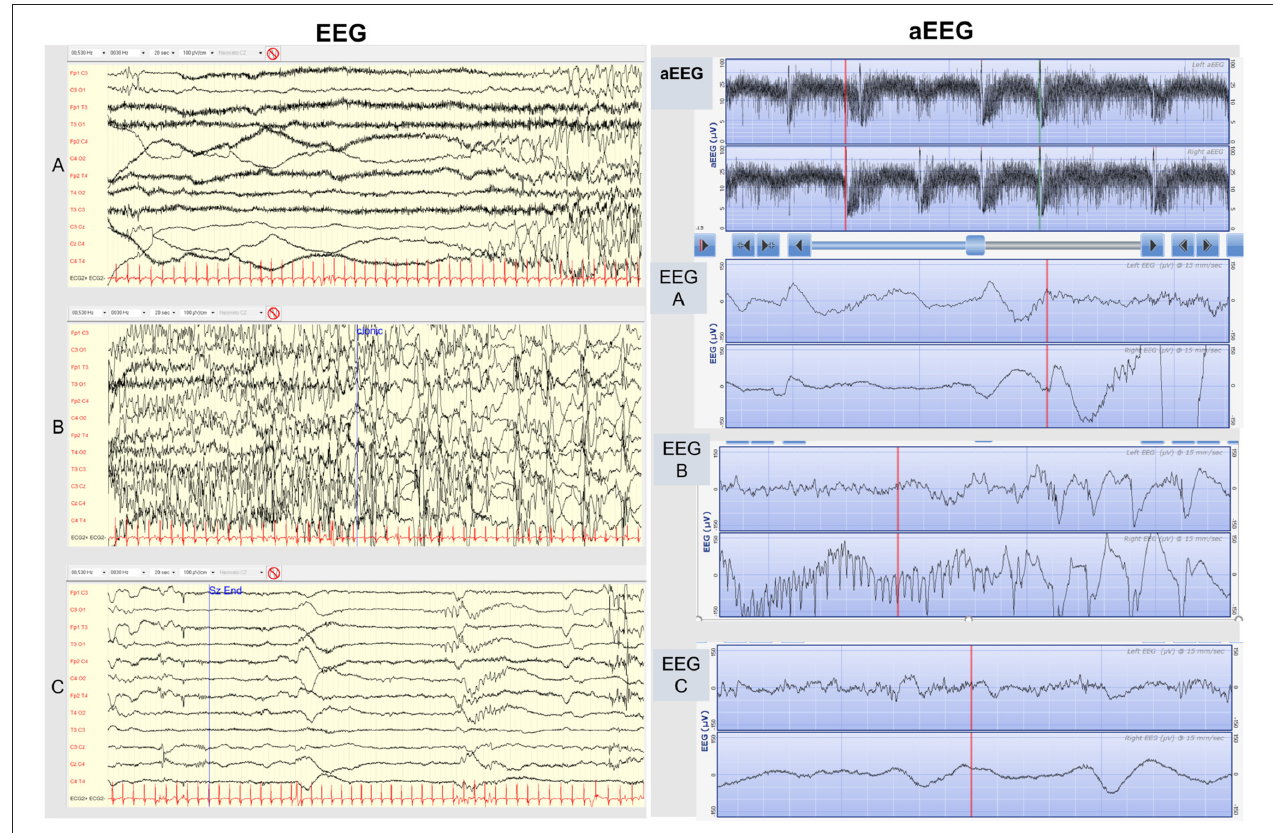
FIGURE 2 | EEG (on the left). Conventional EEG traces of a typical seizure of KCNQ2-related neonatal epilepsy. (A) The initial tonic phase is characterized by ictal low-amplitude EEG appearance mixed with muscle artifact. (B) The following clonic phase is characterized by rhythmic high-amplitude spike-wave activity. (C) Post-ictal low-amplitude depression phase. aEEG (on the right). 2-channel-aEEG (and corresponding EEG raw traces) in KCNQ2-related neonatal epilepsy. Cluster of KCNQ2-related seizures typically characterized by high amplitude peaks enclosed by short troughs. In addition to the first KCNQ2-seizure aEEG pattern description by Vilan et al. we underline the frequent typical appearance in KCNQ2 seizures of a trough preceding the aEEG peak during the initial tonic phase, corresponding in the raw EEG trace to a low-amplitude high-frequency EEG pattern (EEG A) , followed by the aEEG peak pattern during the clonic phase, corresponding in the raw EEG to a high-amplitude rhythmic low-frequency spike (EEG B) , and finally another trough following the peak during the post-ictal depression phase, corresponding to a low-amplitude EEG pattern (EEG C)